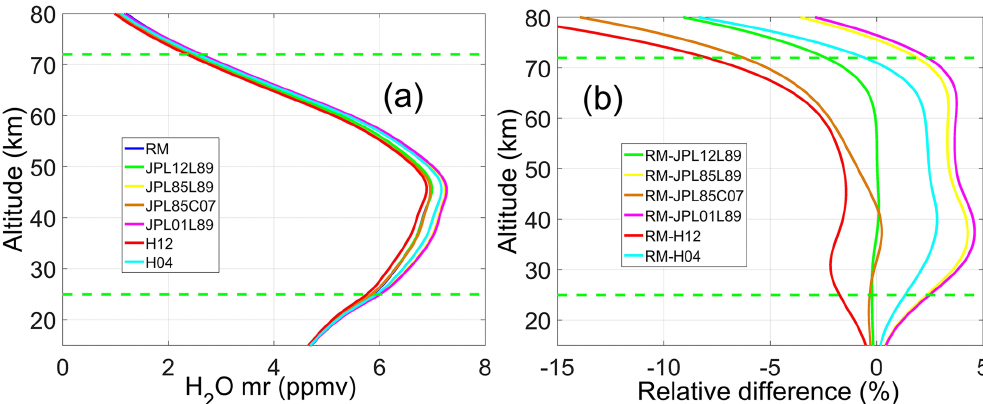
Figure 10. (a) Mean retrieved water vapor profiles obtained using different spectroscopic models (the blue line is the model eventually adopted for the analysis of VESPA-22 spectra, called reference model, or RM). The spectroscopic parameters for the additional models tested are obtained from different versions of the JPL catalogue (years 1985, 2001 and 2012; Pickett et al., 1998) with the pressure broadening parameters taken from Liebe (1989) and Cazzoli et al. (2007). Two models include values from HITRAN 2004 and 2012 (Rothman et al., 2013). Models are indicated in the legend with their abbreviations: JPL2012Liebe1989 (JPL12L89), JPL1985Liebe, 1989 (JPL85L89), JPL1985Cazzoli, 2007 (JPL85C07), JPL2001Liebe, 1989 (JPL01L89), HITRAN2012 (H12), and HITRAN2004 (H04). (b) Vertical profiles of mean relative differences between VESPA-22 profiles obtained using the reference model and the different spectroscopic models. Data represented here range from 4 October 2016 to 22 May 2017. The average retrieval sensitivity range is marked by dashed horizontal green lines.